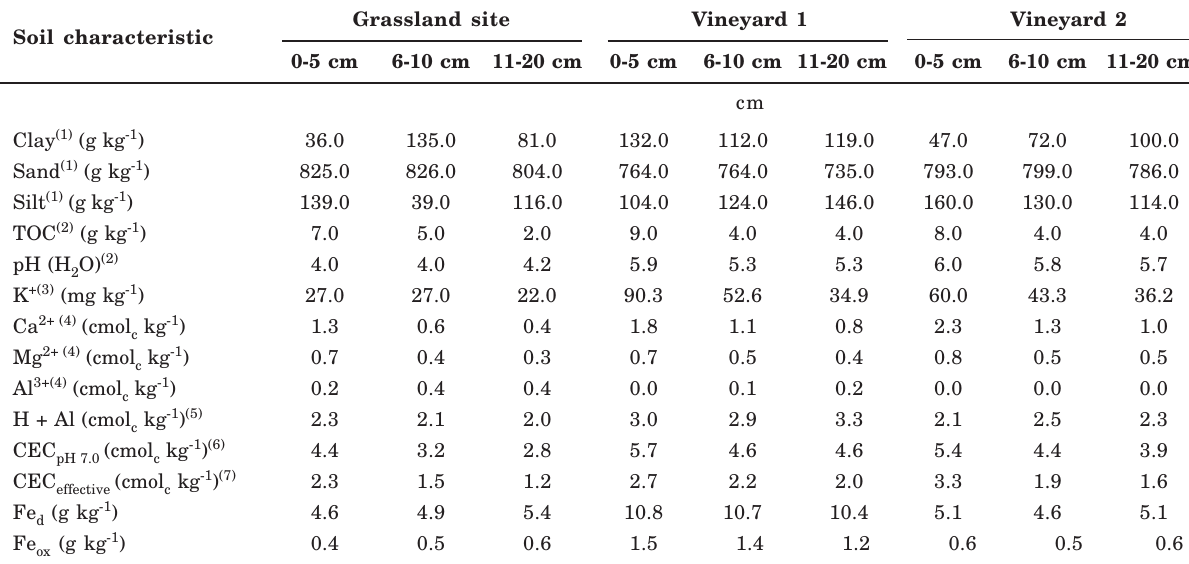
Table 1. Physical and chemical properties of a sandy Typic Hapludalf soil at a grassland site near